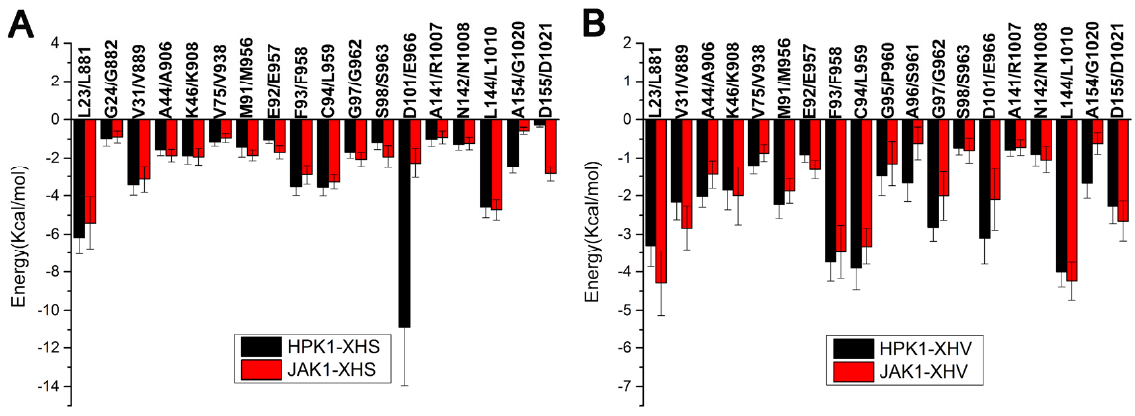
Figure 4. ( A ) Total energy contributions of inhibitor XHS with HPK1/JAK1, ( B ) total energy contri- butions of XHV with HPK1/JAK1.